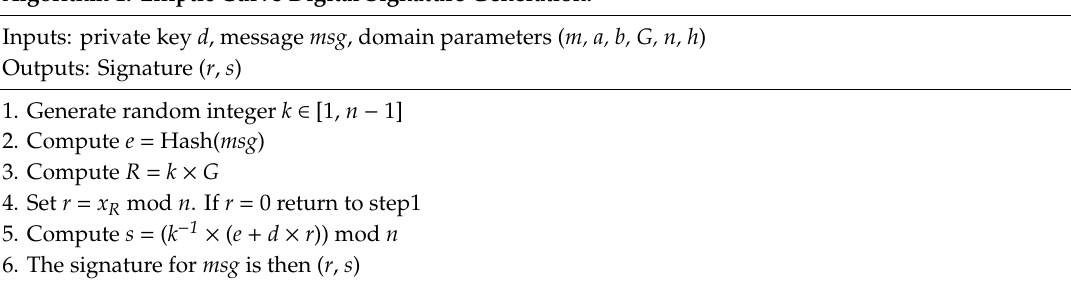
Algorithm 1. Elliptic Curve Digital Signature